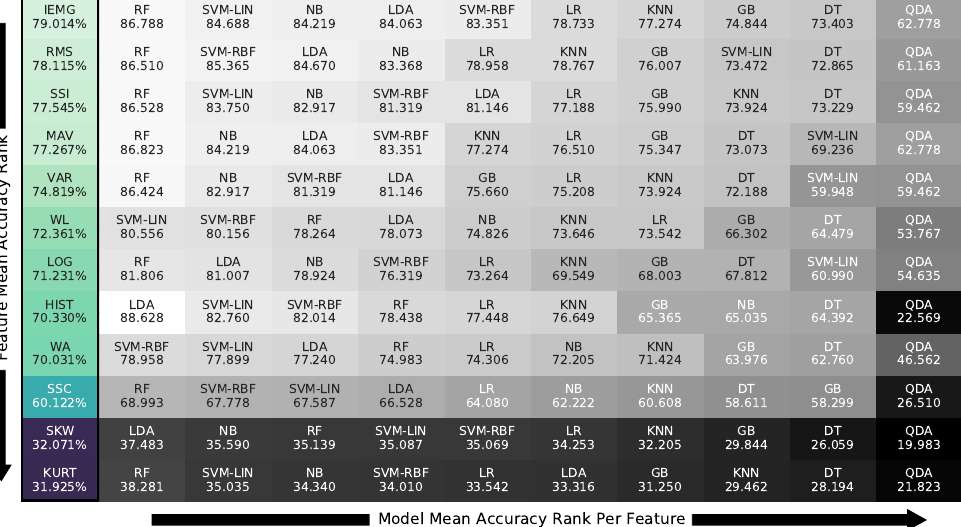
Figure 9. Feature accuracy ranking on the 1250 ms window with the classifiers’ sub-ranking using all participants’ grasp data.